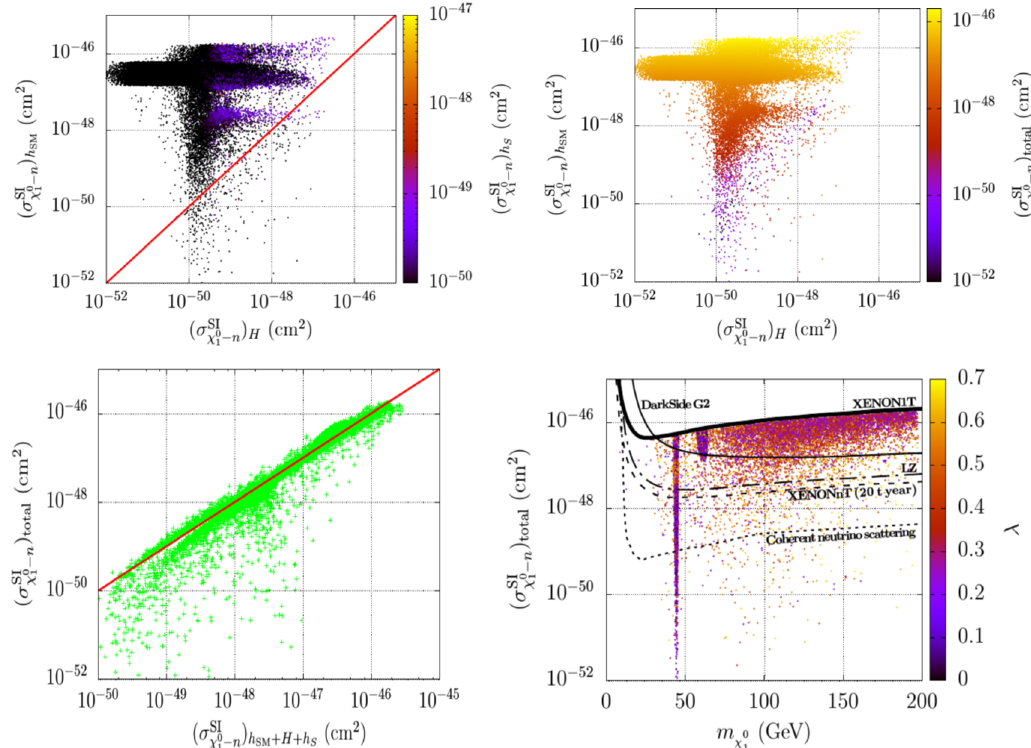
Figure 8 . Scattered points passing all relevant constraints and illustrating the anatomy and in- terplay of various contributions to SI DM-neutron scattering cross section (top panel and bottom, left) and the total SI cross section as a function of m vis-a-vis results/reach from/of various χ 0 1 recent/future experiments with the corresponding magnitude of ‘ λ ’ indicated by the palette (bot- tom,